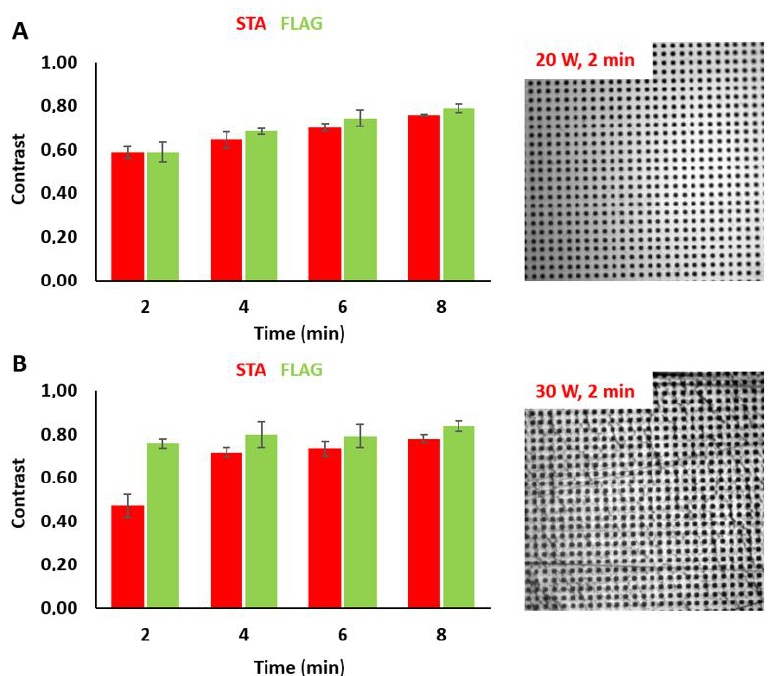
Figure A4. Correlation between plasma treatment time and contrast using different plasma intensities. ( A ) 20 W and ( B ) 30 W. Representative images were obtained at both intensities after 2 min of plasma treatment.